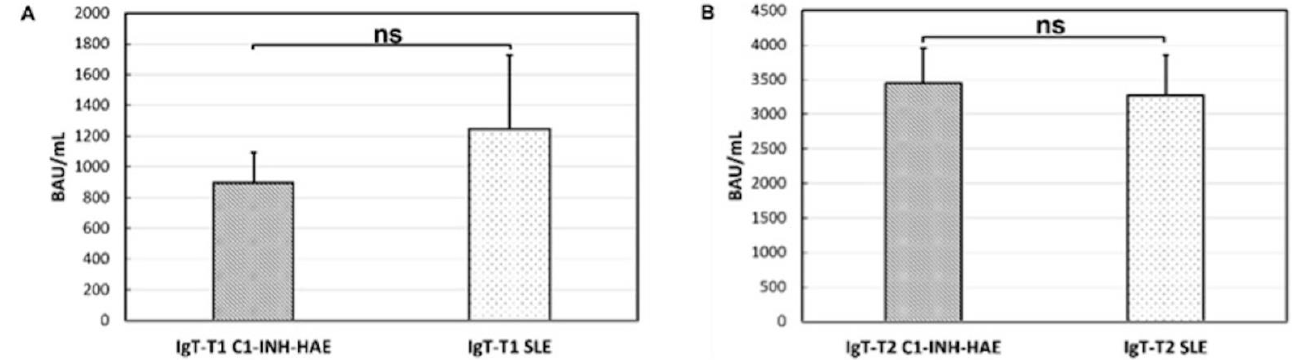
Figure 3. Comparison between anti-SARS-CoV-2-IgG levels at T1 and T2 between systemic erythematous lupus patients (SLE) patients and C1-esterase inhibitor deficiency hereditary angioedema (C1-INH-HAE) controls. No significant difference (ns) was found at T1 [t(52.81) = − 0.68; p = 0.49] ( A ) and at T2 [t(67.74 ) = −0 .22; p = 0.825] ( B ) between the two groups of patients.